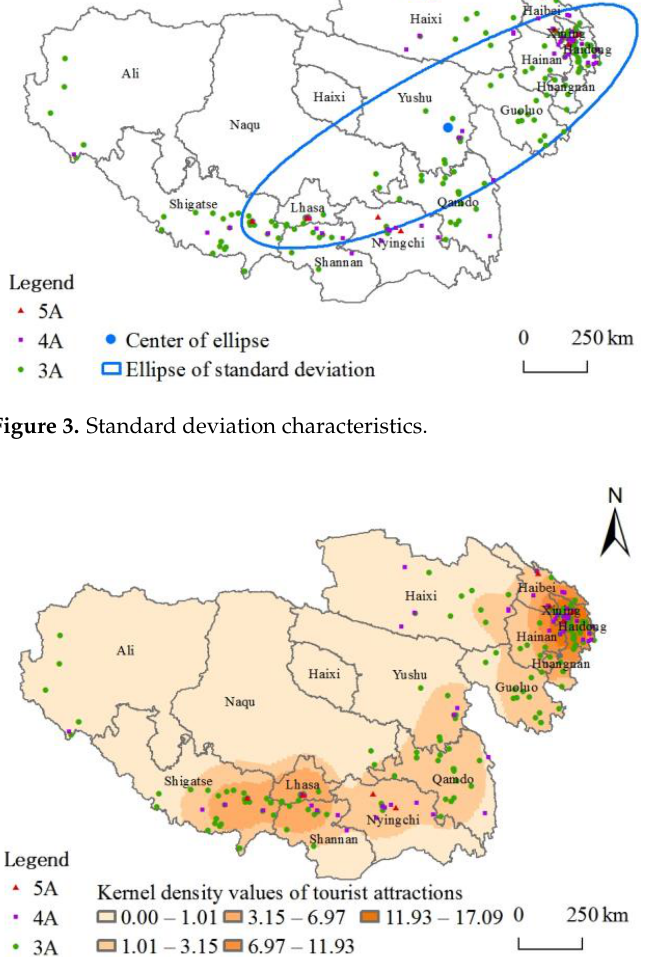
Figure 4. Kernel density characteristics .